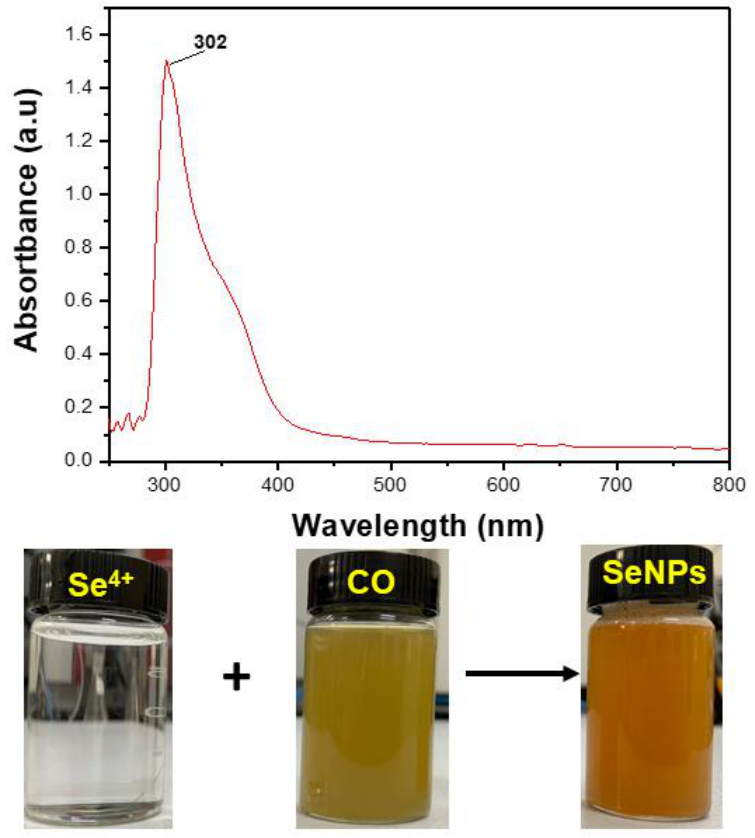
Figure 3. Optical images of Se 4+ precursor, the CO extract, Se NPs, and UV-spectrum of Se NPs prepared with the Se 4+ /CO volume ratio of 1/2.